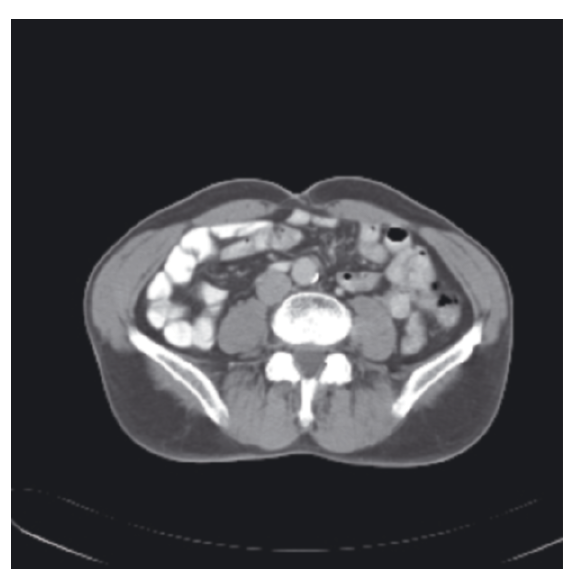
Figure 6. Abdominal computerized tomography scan with contrast. Five years post op, showing no evidence of recurrent